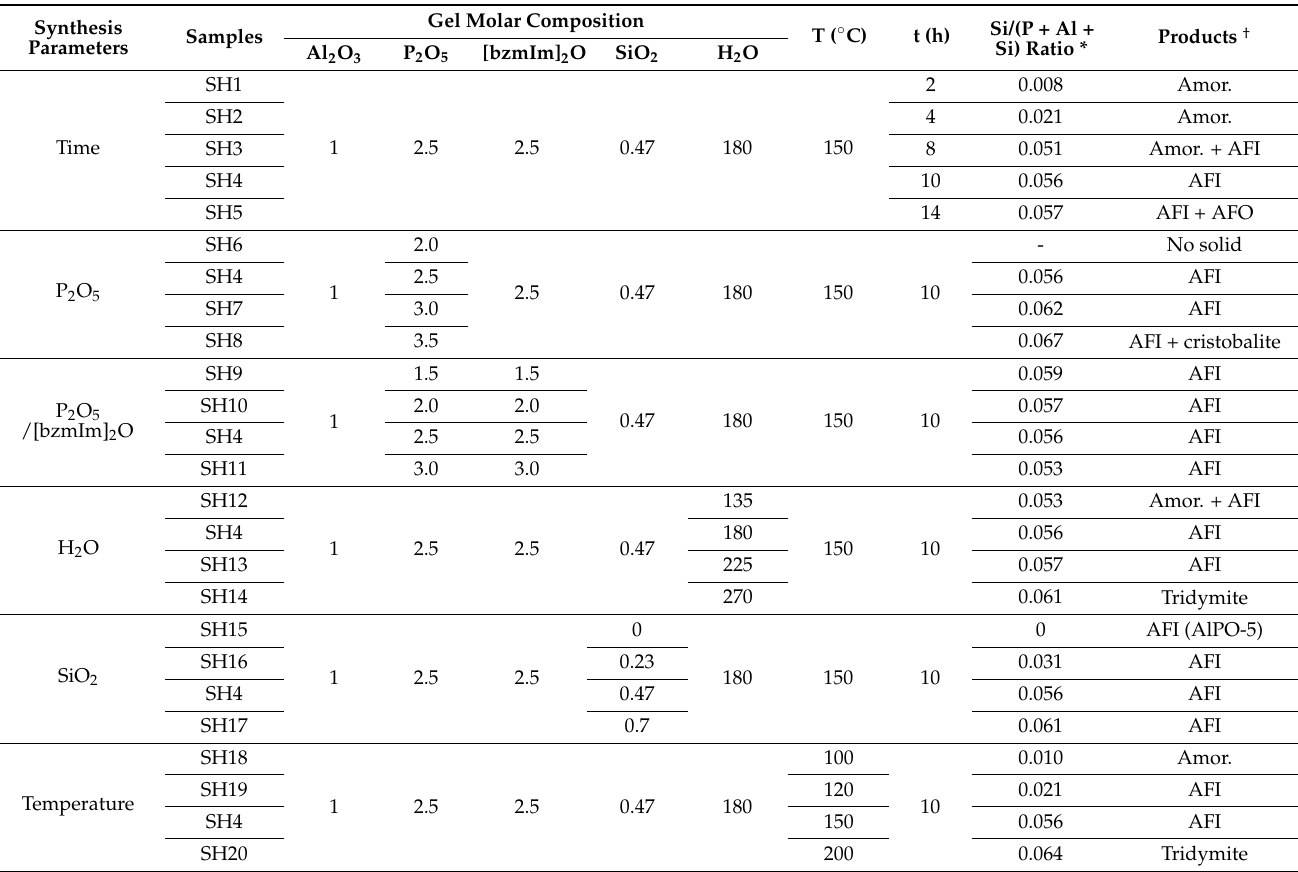
Table 1. Chemical composition and crystallization conditions of SH1–SH20 hydrogels together with the products obtained after altering the individual synthesis parameter. Synthesis Parameters